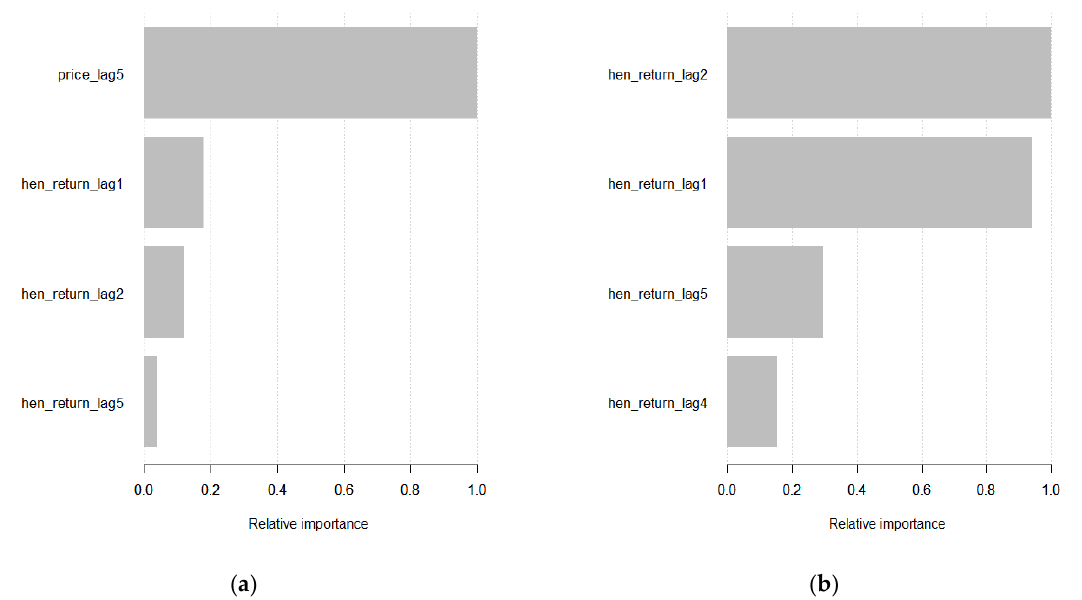
Figure A1 . XGboost variable importance plots: partial variables with the moving window and the expanding window methods. ( a ) the XGboost variable importance plot of the partial variables with the moving window method in the final loop calculation; ( b ) the XGboost variable importance plot of the partial variables with the expanding window method in the final loop calculation.